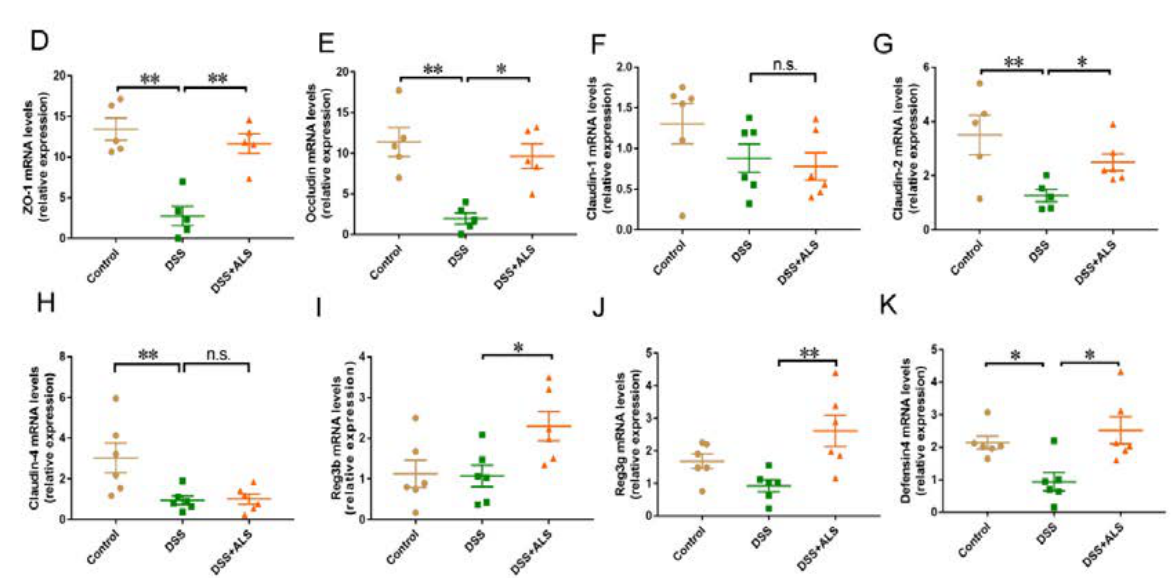
Figure 2. ALS improves intestinal barrier function. ( A ) Representative images of colonic ultrastructure in epithelial cells shown by TEM. ( B ) Representative fluorescent images of ZO-1 in colon. Scale bar = 50 µ m. ( C ) Representative fluorescent images of Occludin in colon. Scale bar = 50 µ m ( D ) Real-time qPCR analysis of ZO-1 in colon tissue. ( E ) Real-time qPCR analysis of Occludin in colon tissue. ( F ) Real-time qPCR analysis of claudin-1 in colon tissue. ( G ) Real-time qPCR analysis of claudin-2 in colon tissue. ( H ) Real-time qPCR analysis of claudin-4 in colon tissue. ( I ) Real-time qPCR analysis of Reg3b in colon tissue. ( J ) Real-time qPCR analysis of Reg3g in colon tissue. ( K ) Real-time qPCR analysis of defensin4 in colon tissue. Data are mean ± SEM. n = 5–6 per group. * p < 0.05 and ** p < 0.01. n.s., not statistically